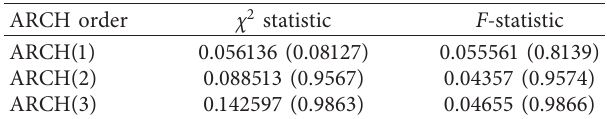
Table 8: ARCH-LM test for standardized residuals of the fitted volatility models.